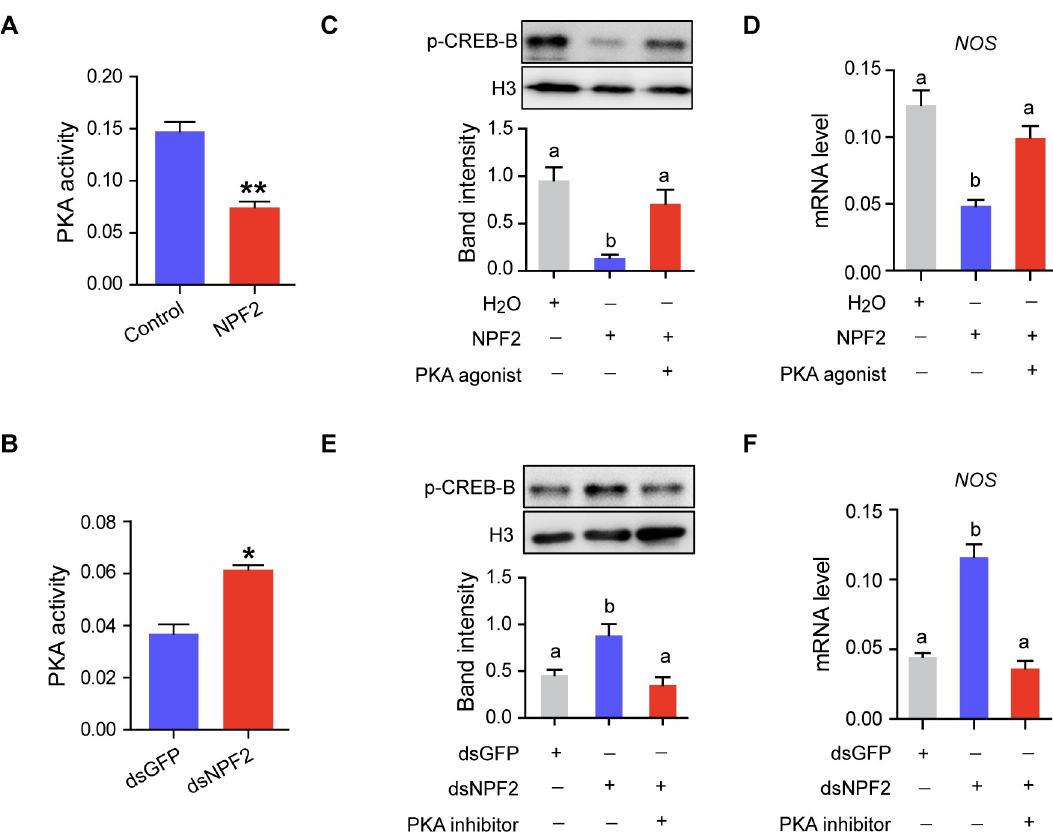
Fig 7. PKA mediates the regulatory effects of NPF2 on CREB-B phosphorylation and NOS transcription. PKA activity after (A) injection of NPF2 peptide in G-phase locusts and (B) transcript knockdown of NPF2 in S-phase locusts (n = 4 replicates, 15–20 locusts/replicate, � P < 0.05, �� P < 0.01 with Student’s t-test). (C) p-CREB-B and (D) NOS transcription levels after the administration of PKA agonist (Colforsin) in G-phase locusts pre-injected with NPF2 peptide. (E) p-CREB-B and (F) NOS transcription levels after the administration of PKA inhibitor (KT5720) in S-phase locusts pre-injected with dsNPF2 (n = 3 replicates, 6–8 locusts/replicate for qPCR, 8–12 locusts/replicate for western blot, one-way ANOVA, P < 0.05).